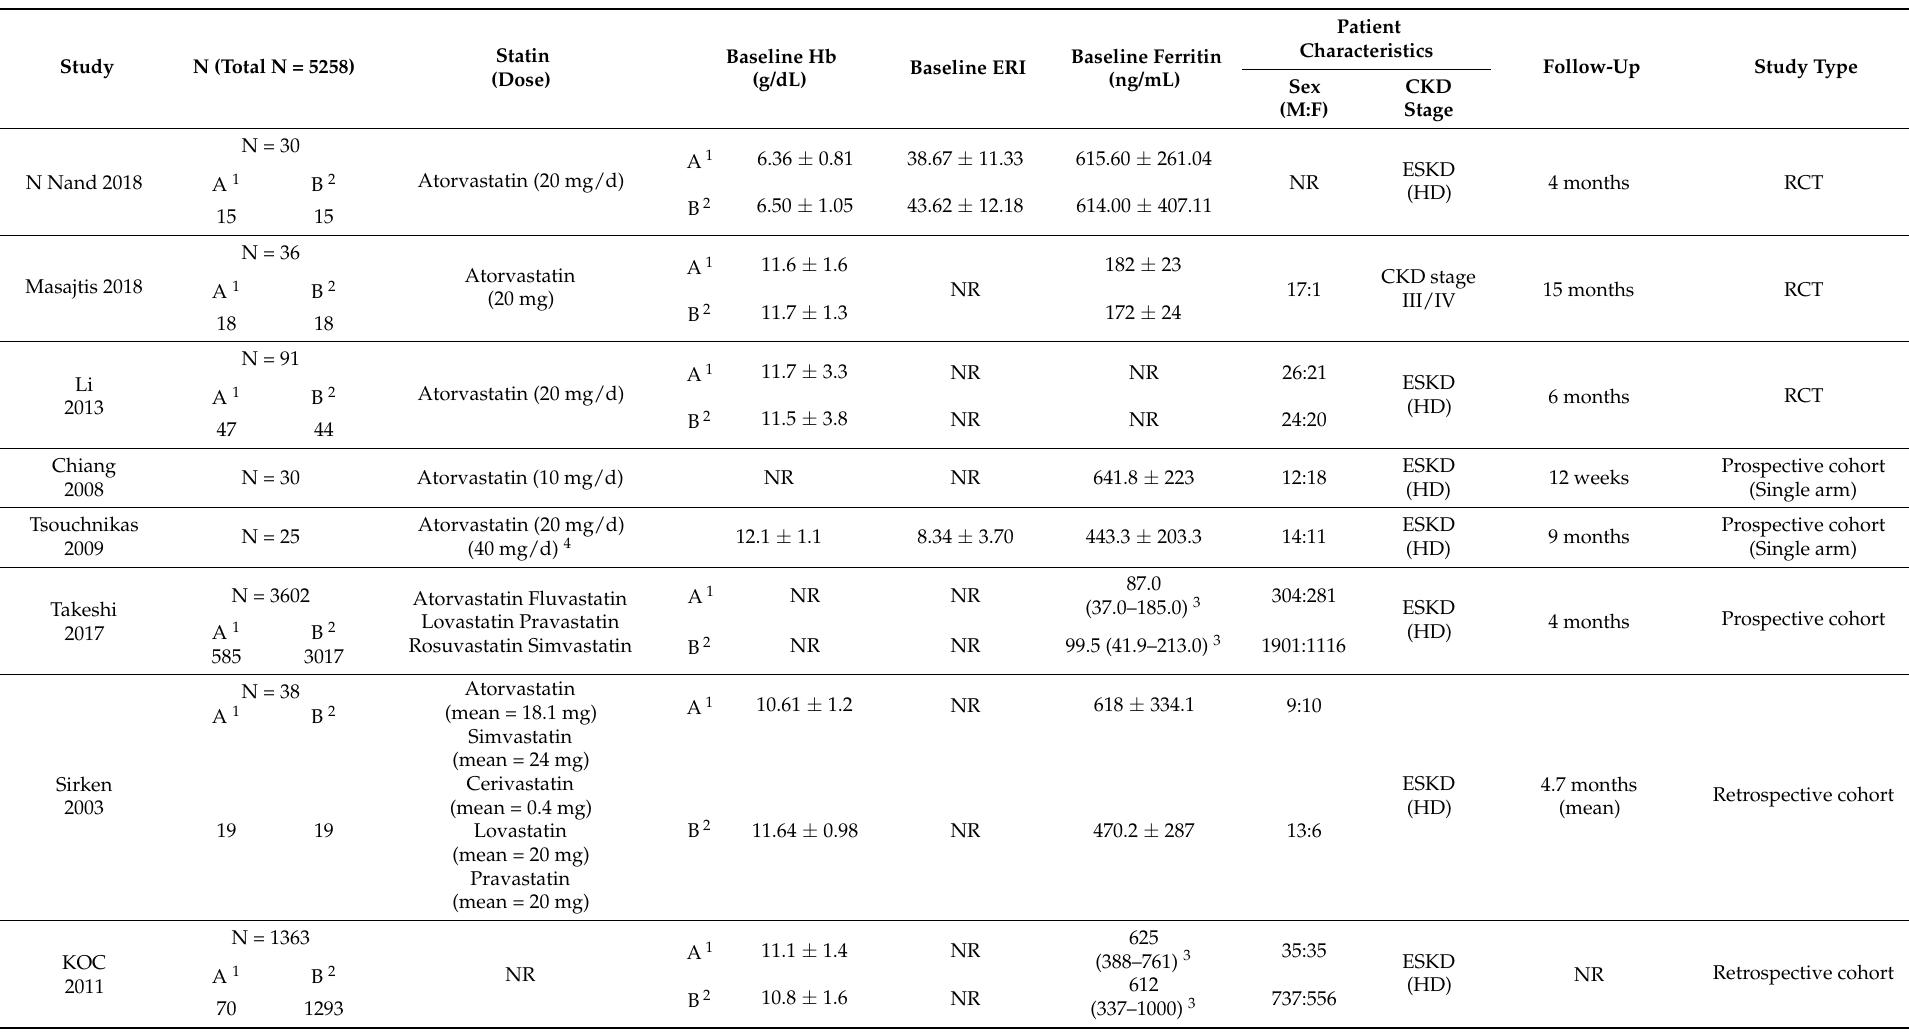
Table 1. Summaries of included papers in the